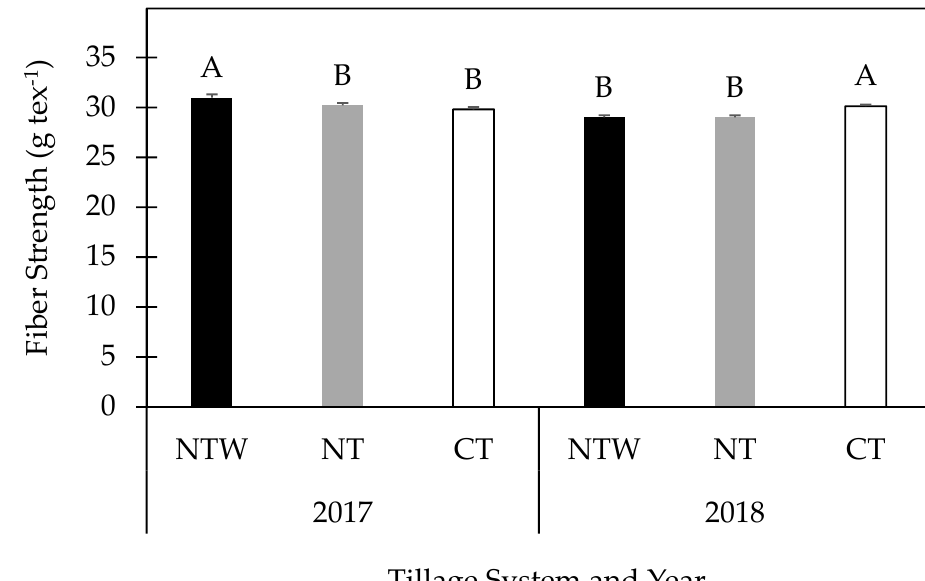
Figure 3. Fiber strength differences due to tillage system in 2017 and 2018. NTW, no-till with winter wheat cover; NT, no-till winter fallow; CT, conventional tillage winter fallow. Bars are standard error of the mean. LSD letters are compared within year and are significant at p < 0.05.